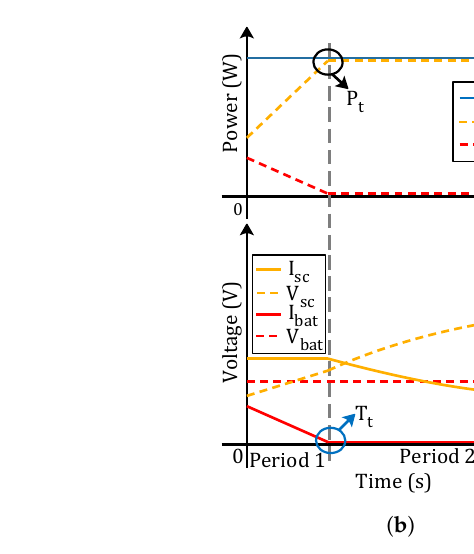
Figure 7. Charging curves of HESS and WPT for ( a ) V sci = V scmin ( b ) V sci > V scmin